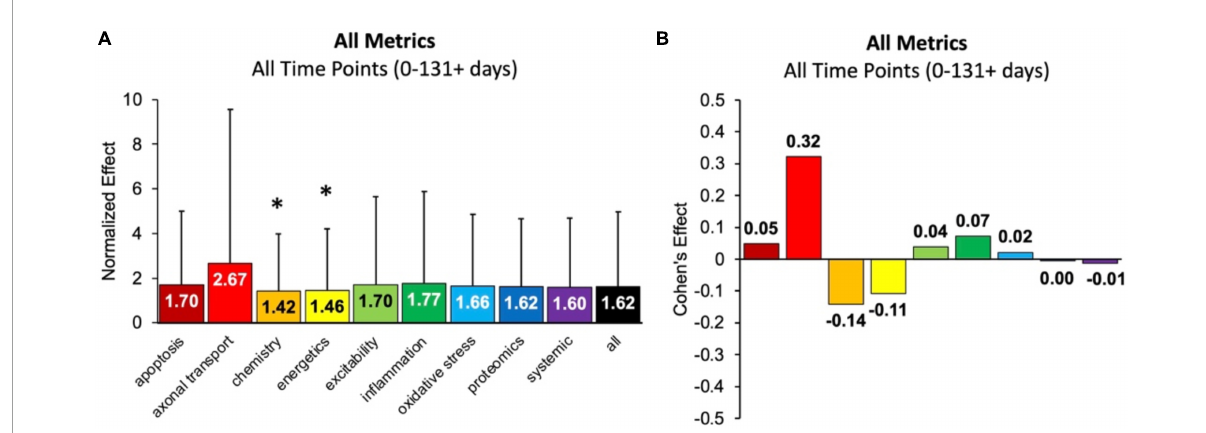
FIGURE1 Analysis of pathophysiological treatment category performance aggregated across all mouse age groups (0–131 + days). (A) Normalized effect size for each pathophysiological treatment category. Error bars represent standard deviation. Each pathophysiological treatment category was compared to the “all” treatments category (black bar) with ∗ denoting a significant difference ( p < 0.05). (B) Calculated Cohen’s effect size (also known as Cohen’s d ) for each pathophysiological treatment category. Cohen’s effect is a statistical measure of each pathophysiological treatment category’s effect size relative to the “all” treatments category (e.g., all pathophysiological treatment categories combined).